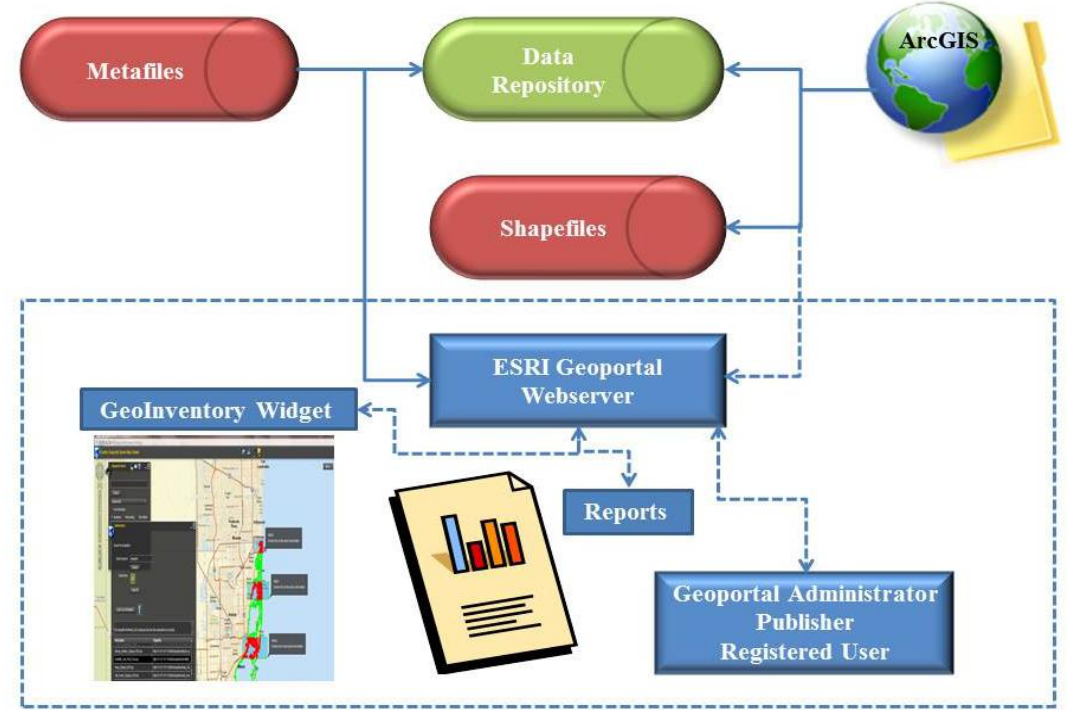
Figure 2. Conceptual diagram of the customized ESRI Geoportal webserver.